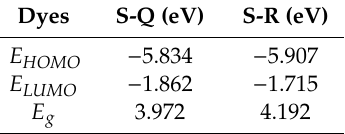
Table 1. Energy levels of S-R and S-Q in the solvent of ethanol.